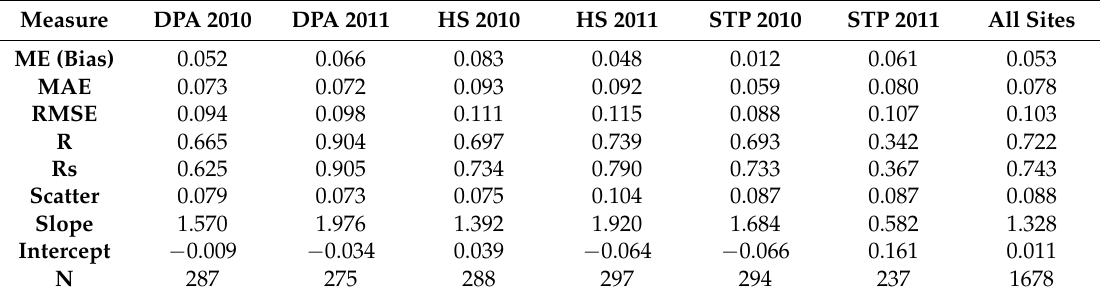
Table 6. Comparison between Satellite (ASCAT 25Km) and observed SSM at validation sites in AUSTRALIA based on land cover type for 2010 and